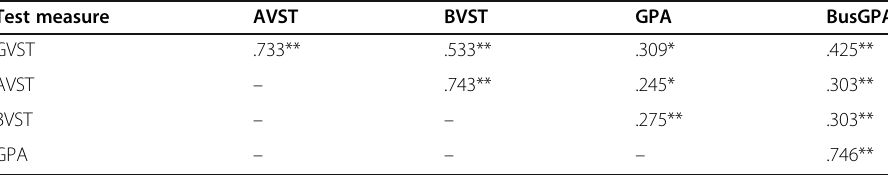
Table 2 Inter-test